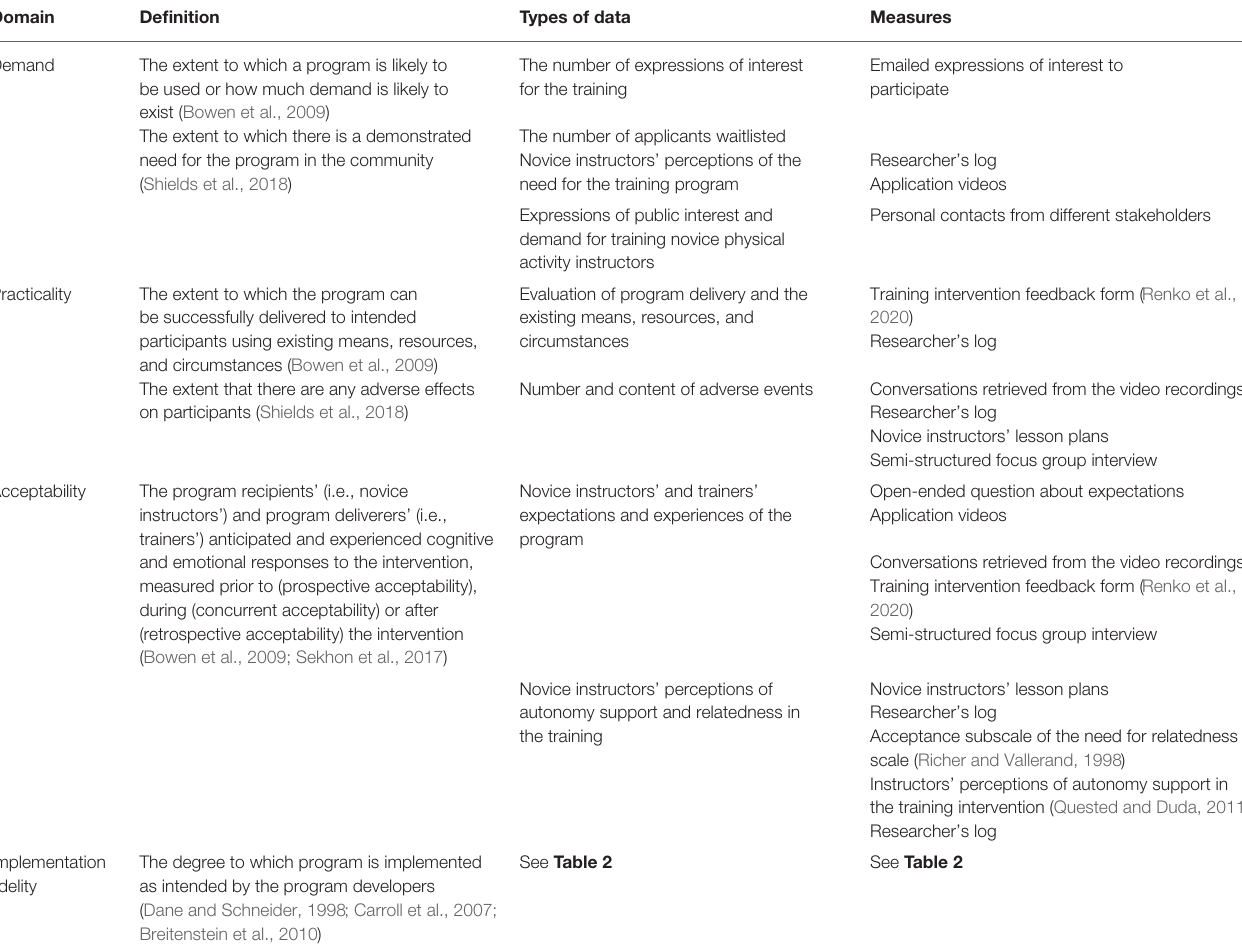
TABLE 1 | The definitions, types of data, and measures of the examined feasibility domains of Bowen et al.’s (2009) evidence-based framework.